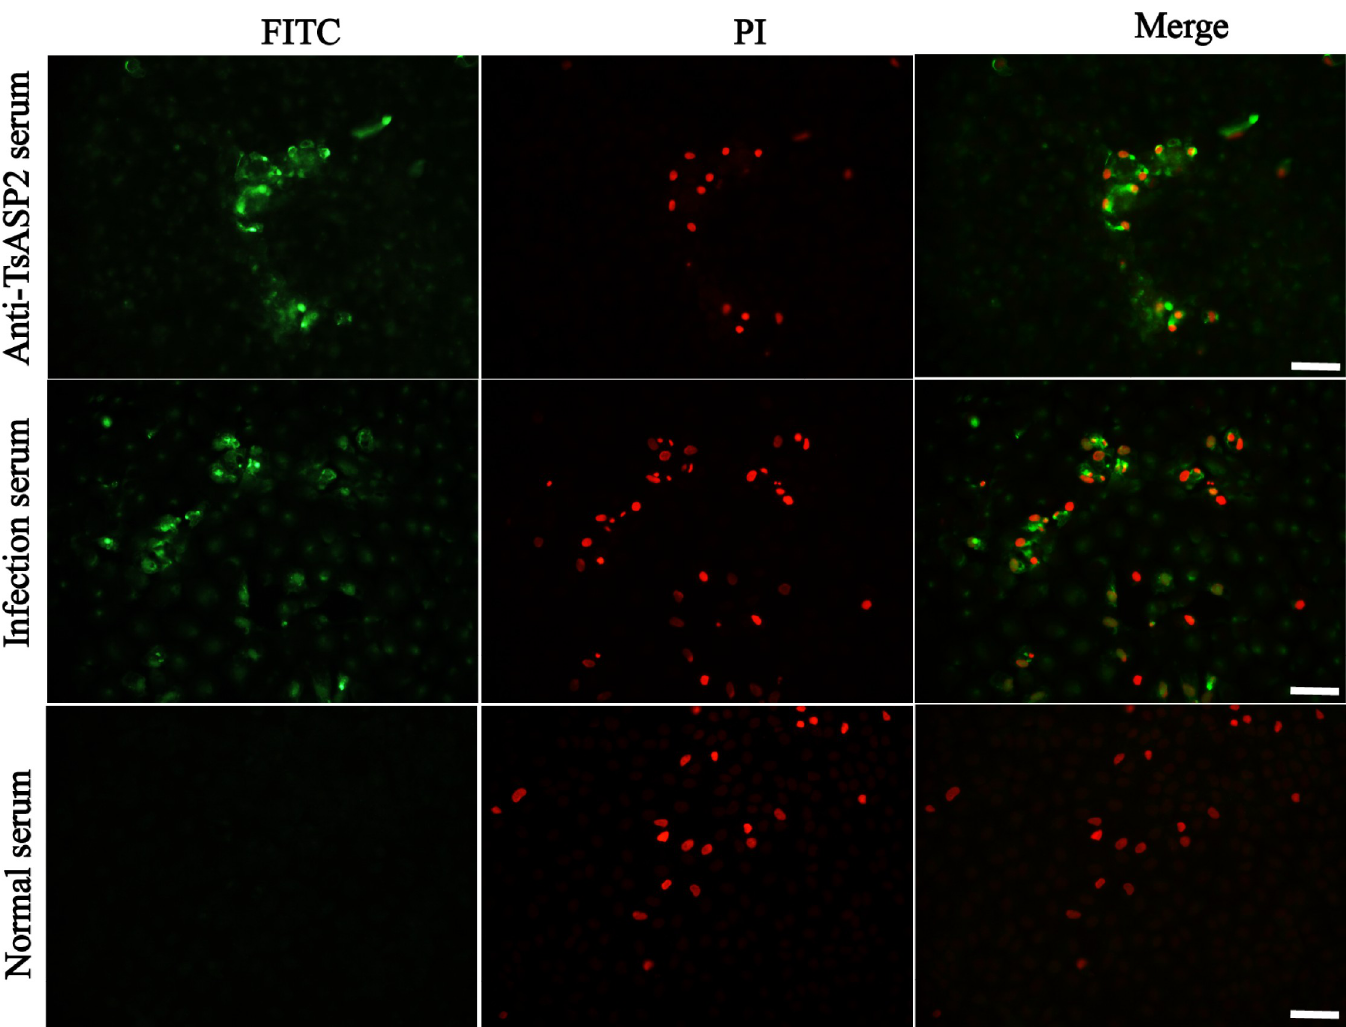
Fig 10. Microscopy of damaged cells following larval penetration. The IEC monolayer was stained with PI (red), and the antigen present on the damaged cells was detected with anti-rTsASP2 serum and infection serum and visualized as green fluorescence. No immunostaining was observed with normal serum. Scale bar: 50 μ